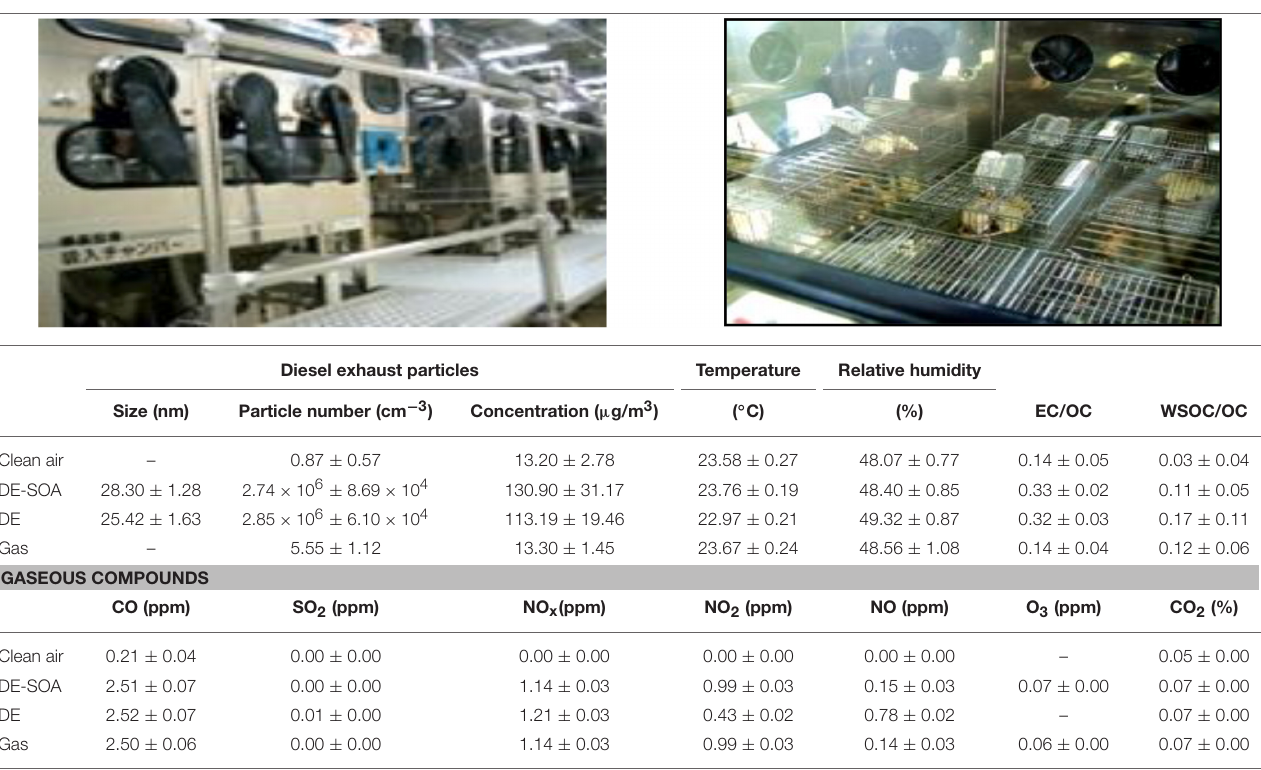
TABLE 1 | Characteristics of diesel exhaust particles and gaseous compounds in the exposure